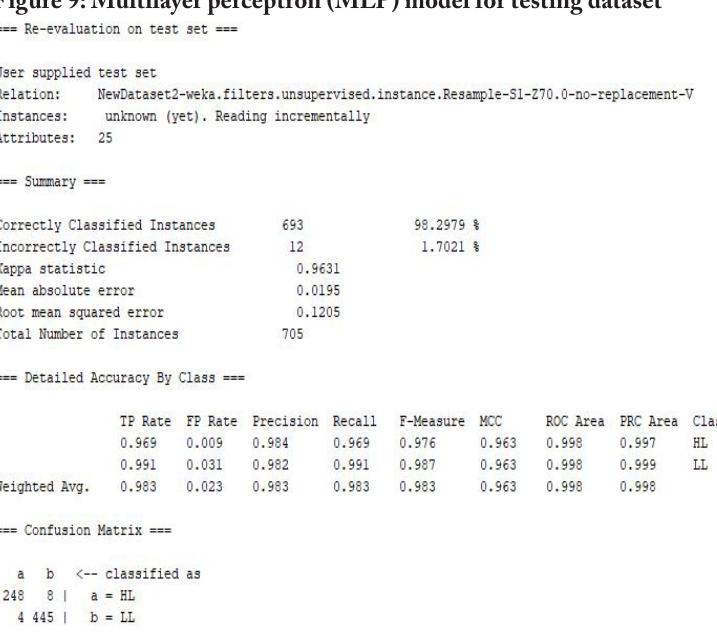
Figure 9: Multilayer perceptron (MLP) model for testing dataset